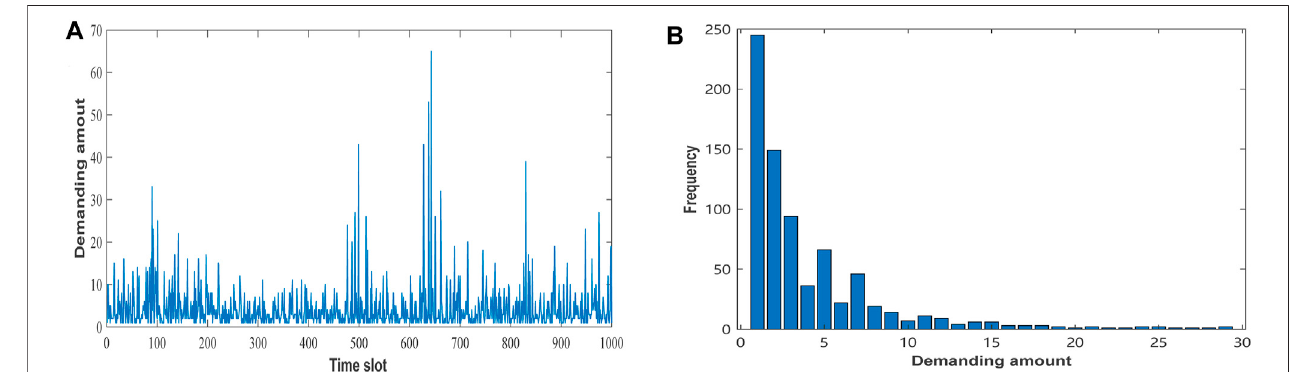
FIGURE 4 | Demanding amount of Google dataset.